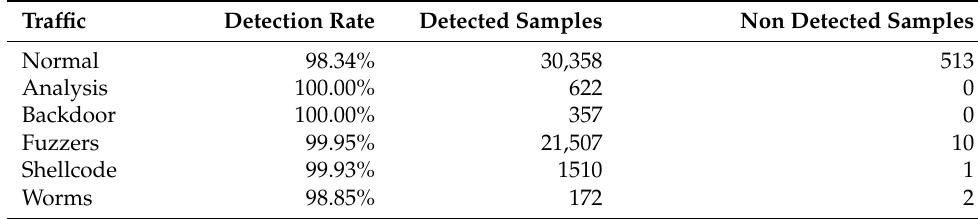
Table 10. Attack detection summary UNSW-NB15 dataset: Zero-day attacks.